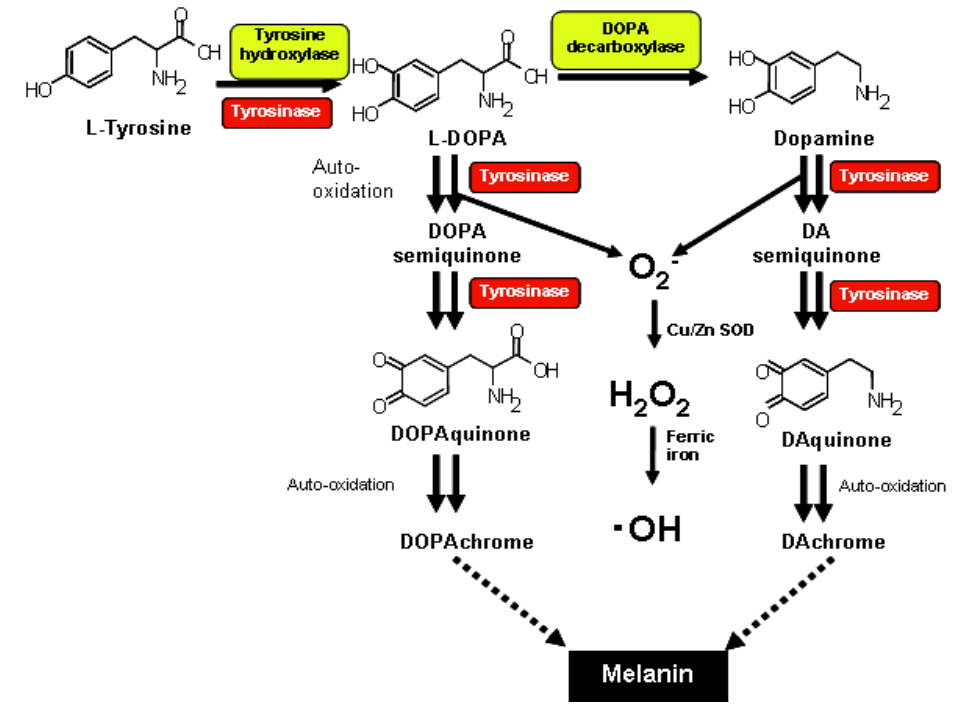
Figure 1. Generation of cytotoxic catechol o -quinones and other reactive oxygen species during the enzymatic action of